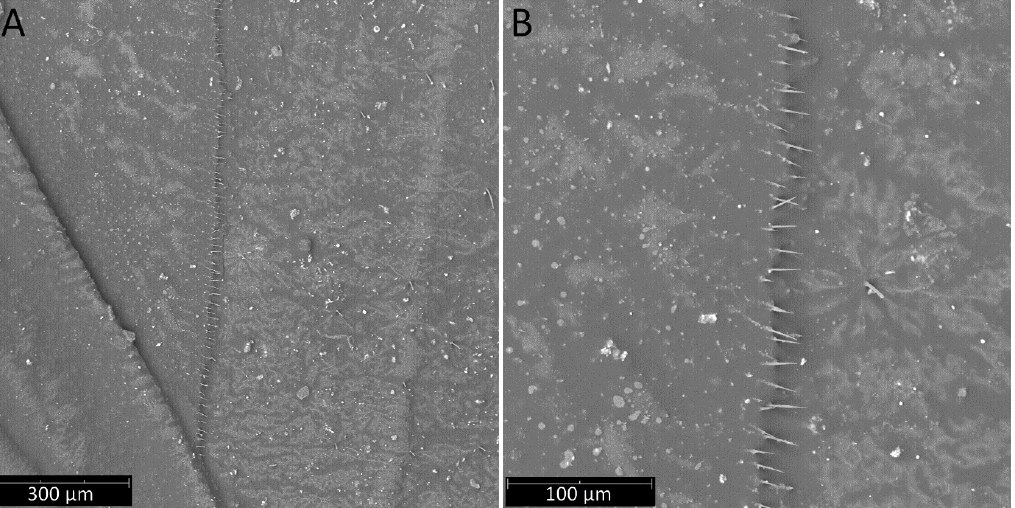
Figure 21. ‘( A-B ) Dorsal surface of the fore wing of Phonoctonus fasciatus (Beauvois, 1805). Figure 21. ( A , B ) Dorsal surface of the fore wing of Phonoctonus fasciatus (Beauvois, 1805). Legs : Relatively long with short setae. Ventral side of the fore and middle femur is covered with very dense and short setae. Femur gradually narrows into the apex with a visible subapical enlargement; tibia is distinctly thinner than the femur, distinctly extended apically and covered with medium-sized and short setae. The third tarsomere, the longest (longer than the first and second combine), has claws the same length or longer than the first tarsomere. Fossula spongiosa and foretibial comb (a brush-like structure used for grooming) are placed on the spur at the fore tibia (Figures 22 and 23A–C). Tenant hairs on the fossula spongiosa basically have two forms—rounded or pointed at the end and flat or spoon-shaped (Figure 24). Pretarsus has symmetrical claws and basal tooth on each claw (Figures 23D and 25). Lateral and ventrolateral setae are on the rim on the distal tarsomere. Parempodial setae are flattened along the entire length. In the ventral view of the pretarsus are the lateral and ventral surfaces of the unguitractor plate, and parempodial sclerite and membrane with microtrichia (Figure 23E). At the end of the third tarsomere, next to the pretarsus, are sensilla trichoidea and chaetica (Figure